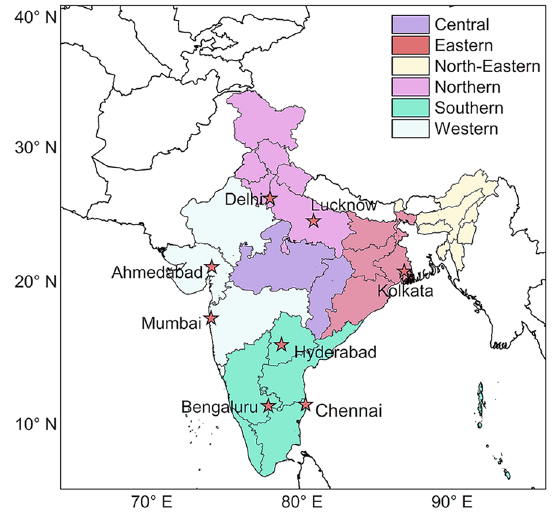
Figure 1. The simulation domain with the location of major Indian cities selected for analysis.